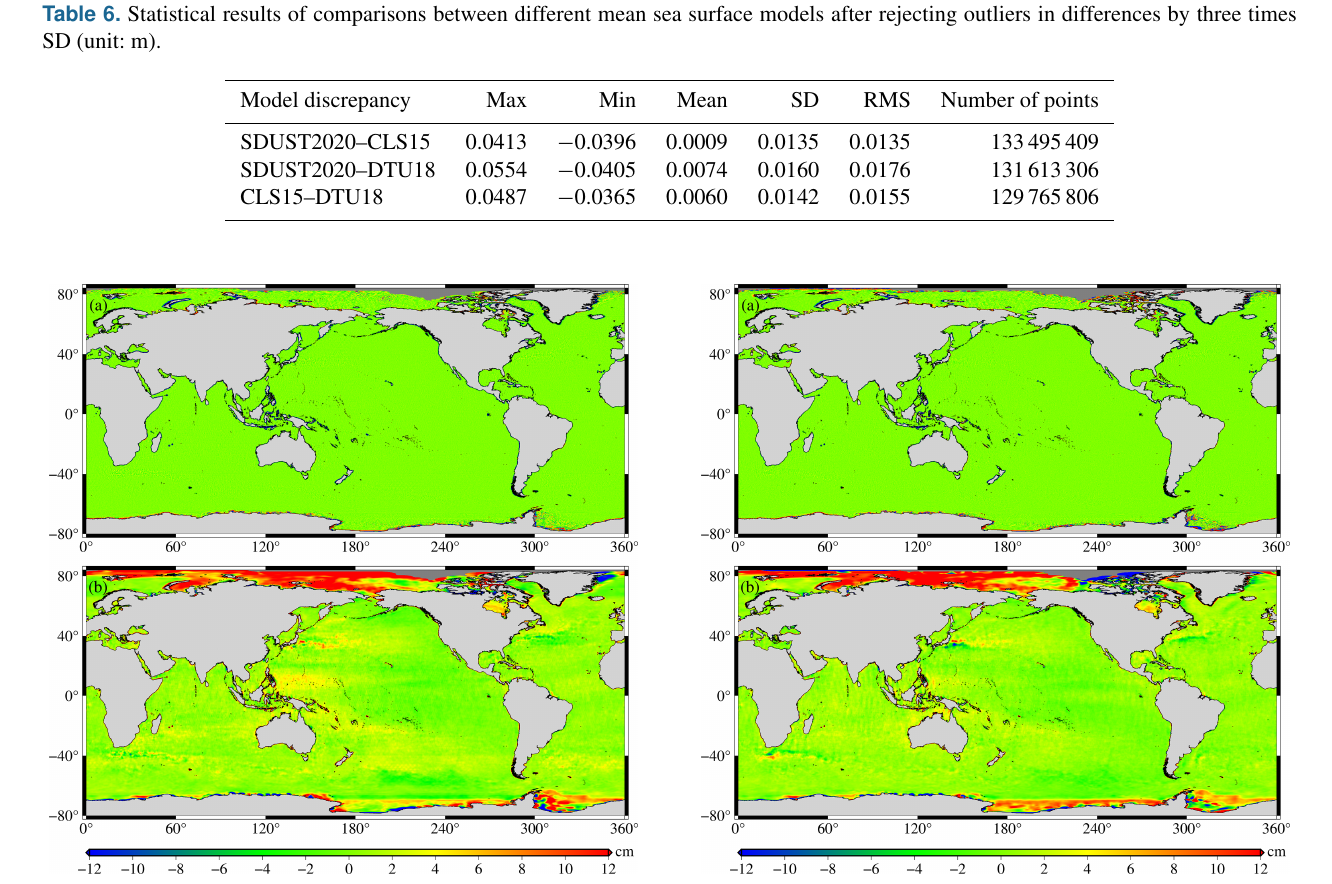
Figure 7. Differences between SDUST2020 and DTU18: (a) wave- length less than 150km and (b) wavelength greater than 150km.